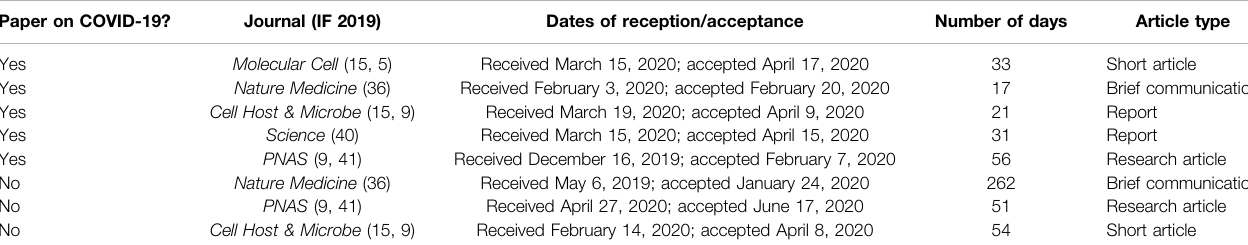
TABLE 2| Summaryofselectedarticles, indicating thejournal and itsimpact factor, alongwiththenumber ofdaysto fi nalacceptance, and thearticletype, i.e.,short (green) vs. long (orange) articles. Paper on